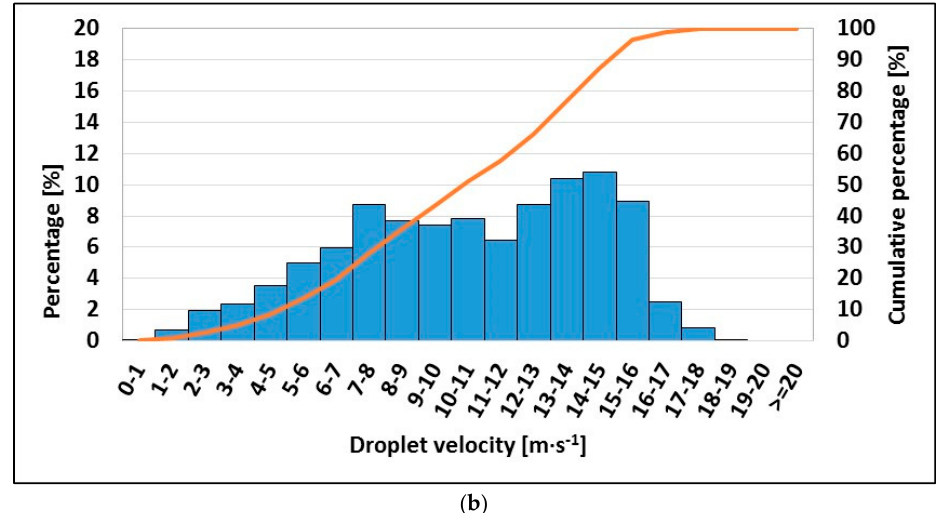
Figure 10. Droplet diameter ( a ) and droplet velocity ( b ) scatter plotted for E1 in position A.